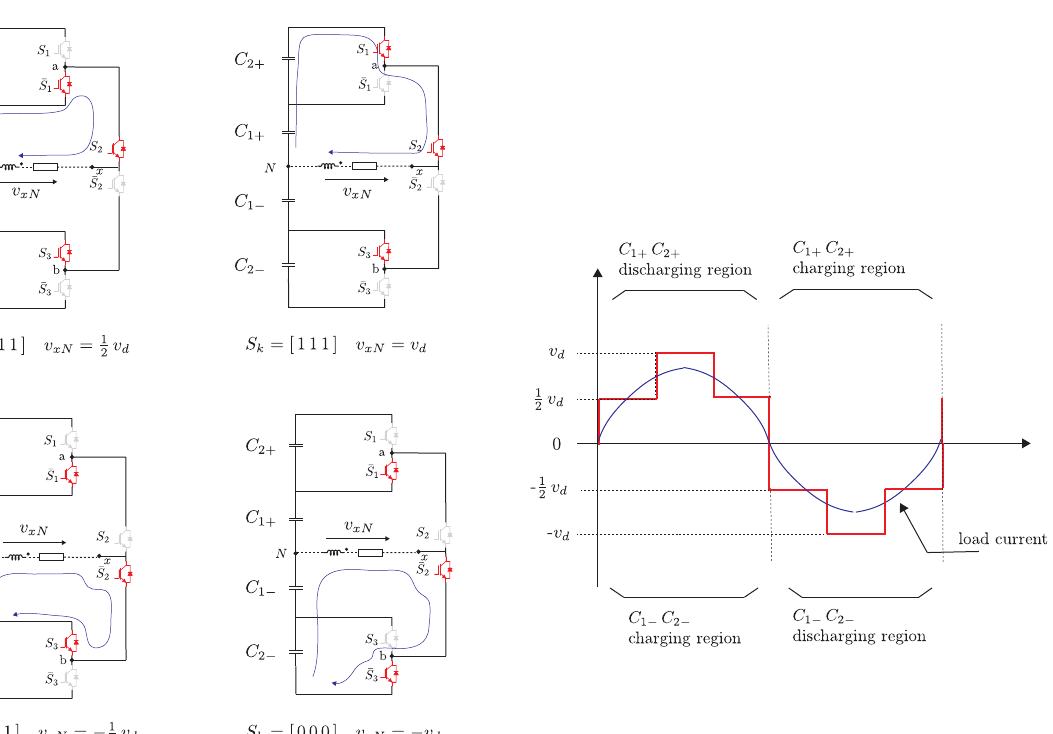
Figure 6. DC-link voltage balancing in the proposed